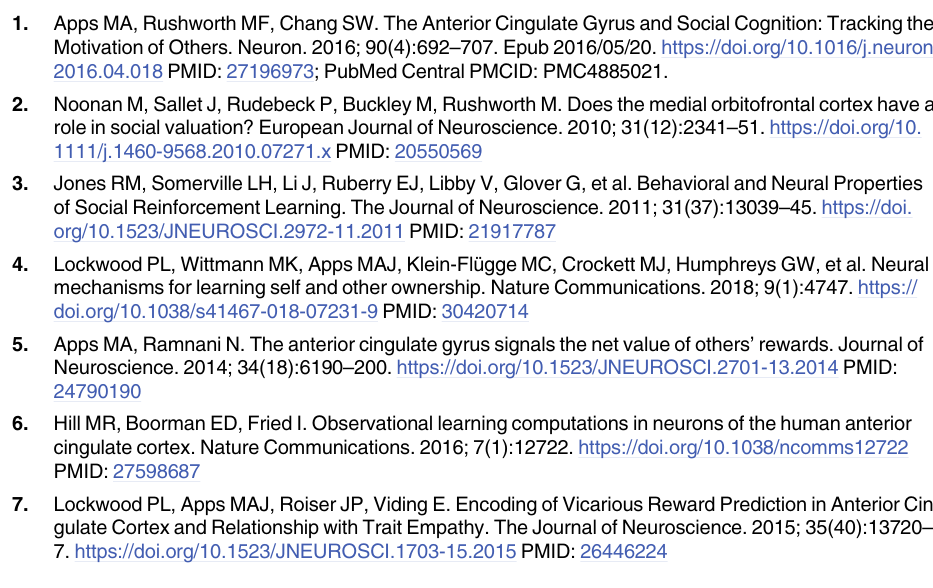
S2 Data. Mean pupil change data related to Fig 3 and S3 Fig. See S2 Data Readme for more information.